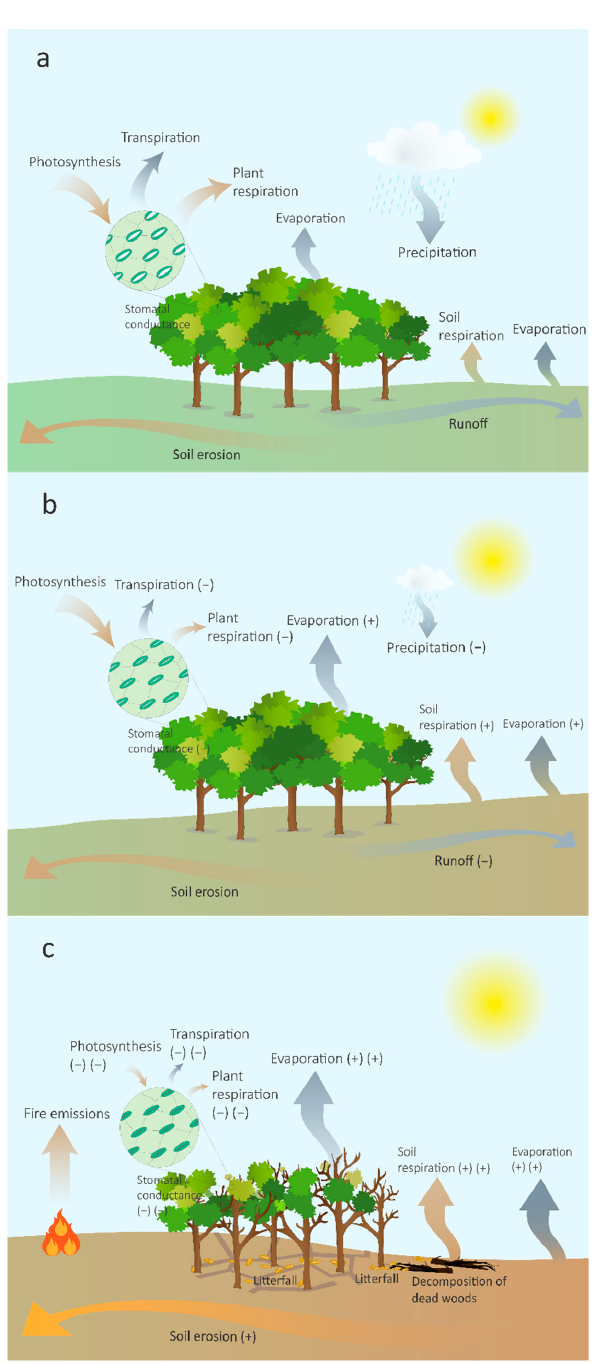
Figure 1. Forest carbon and water fluxes change as the intensity of drought increases. ( a ) Before drought events. ( b ) Moderate drought without tree mortality. ( c ) Severe drought with large biomass loss. Orange arrows show the carbon flux; blue arrows show the water flux. The magnitude of fluxes is indicated by the size of arrows. Numbers of (+) and ( − ) indicate that the degree of fluxes increase and decrease, respectively. Plant respiration includes leaf and stem respiration; soil respiration includes autotrophic soil respiration (roots) and heterotrophic respiration (litterfall, microbial community, soil organic matter,